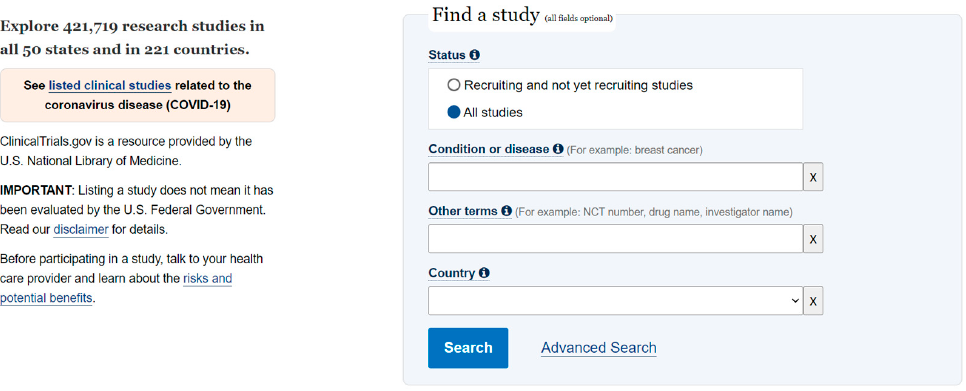
Figure 1. Dashboard of ClinicalTrials.gov.